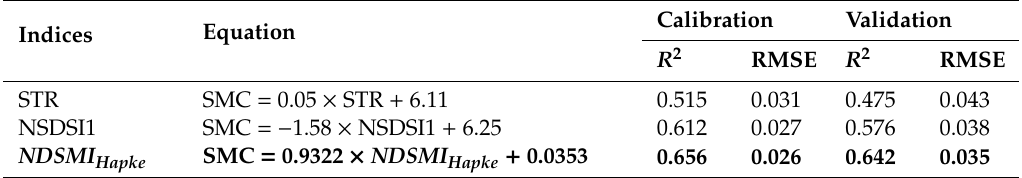
Table 6. Relationship between SMC and SMC indices in broadband Sentinel-2 data.